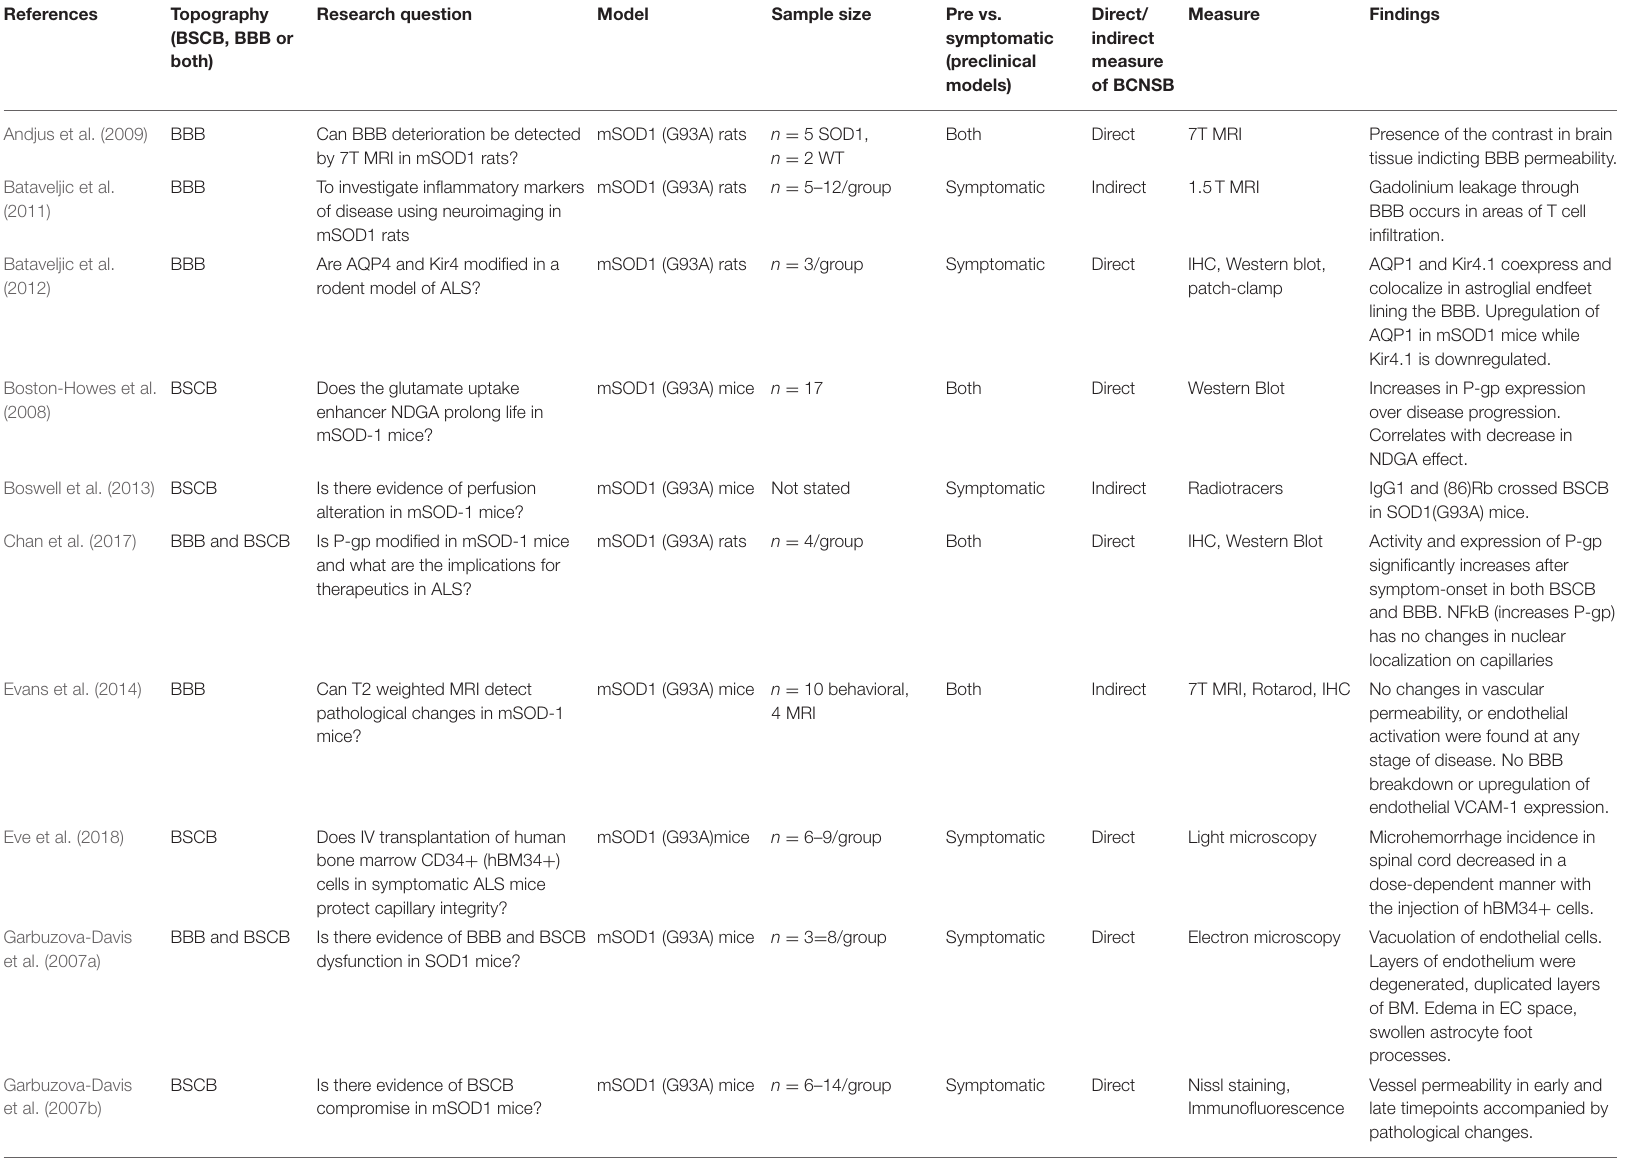
TABLE 1 | Preclinical studies investigating BCNSB integrity and function in